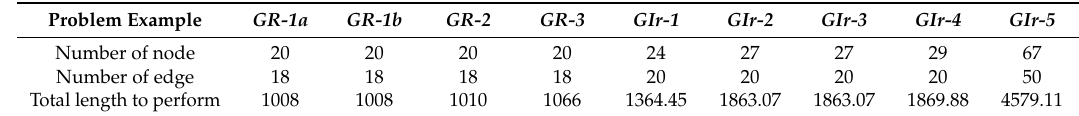
Table 3. Network data.